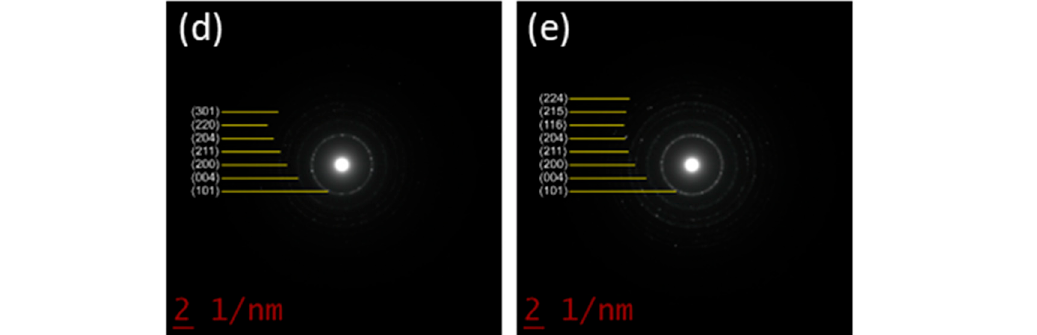
Figure 3. SAED pattern images of: ( a ) TiO 2 ; ( b ) Co/TiO 2 ; ( c ) Cu/TiO 2 ; ( d ) Fe/TiO 2 ; and ( e ) Ni/TiO 2 .